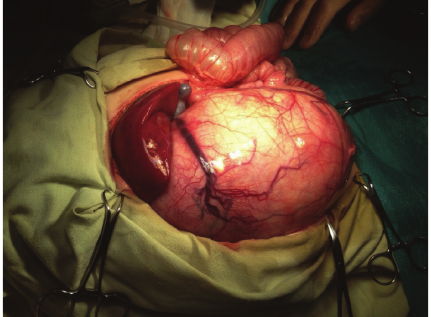
Figure 2: Partial tumor